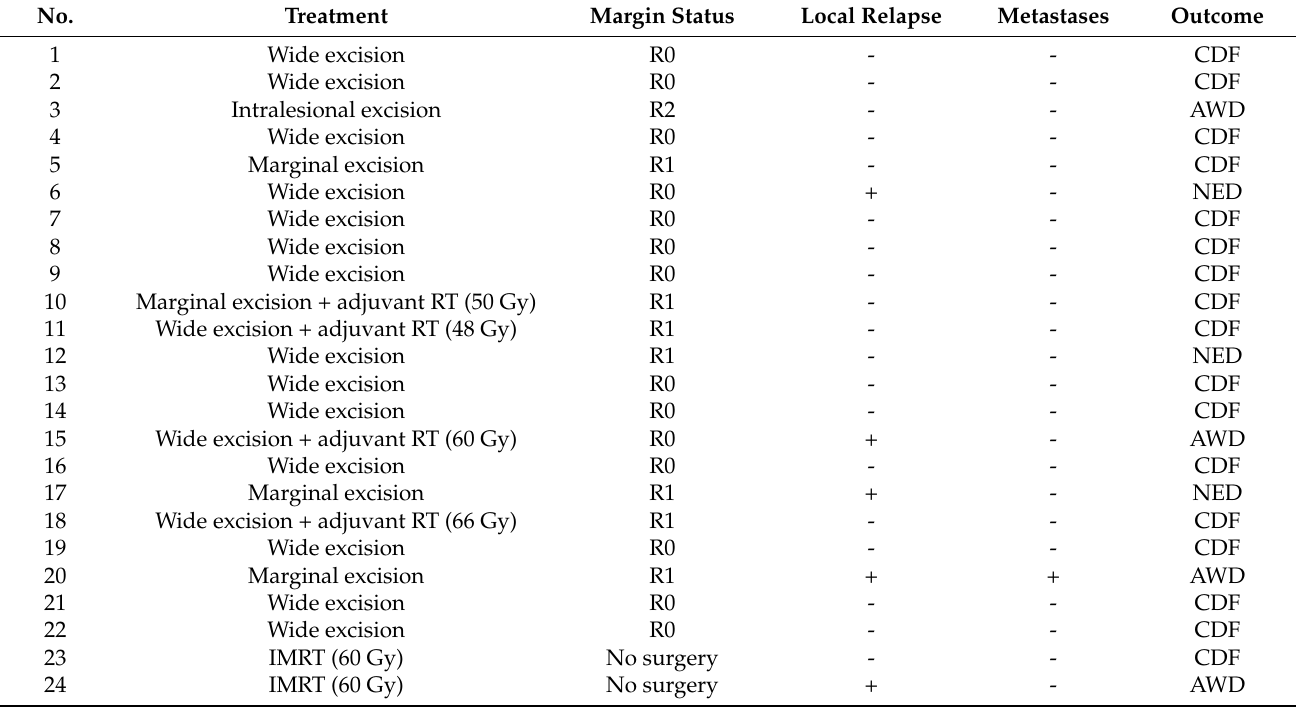
Table 2. Treatment and outcome of initial